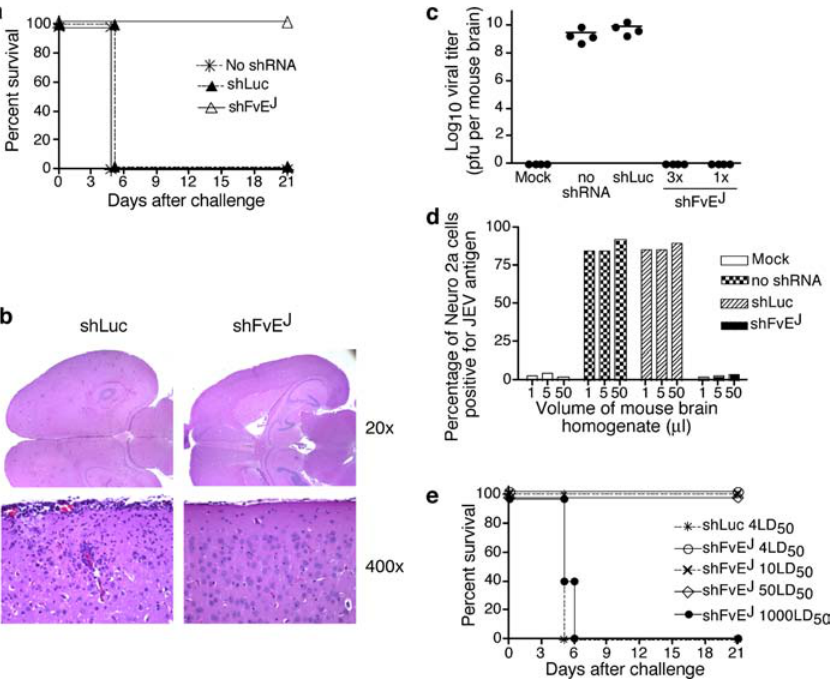
Figure 2. shFvE J Protects Mice against JEV-Induced Encephalitis (A) BALB/c mice (ten per group) were injected IC on days (cid:1) 4, (cid:1) 2, and 0 with 2 3 10 5 TU of either shFvE J or shLuc lentiviruses. On day 0, 30 min after injection of the third dose of lentivirus, they were injected at the same spot IC with four LD 50 of JEV, and the mice were monitored for survival over time. (B) Brain sections from shFvE J treated mice reveal no flavivirus-induced pathology. Representative photomicrographs of hematoxylin and eosin-stained horizontal brain sections obtained from mice treated with shFvE J or shLuc lentivirus and infected with JEV for 5 d are shown at indicated magnifications. (C) Lack of infectious virus in the brains of shFvE J -treated mice. Mice were injected with lentiviruses and challenged with JEV as in (A), and their brain homogenates, obtained 5 d after JEV challenge, were plaque-titrated on BHK21 cell monolayers. For shFvE J lentivirus, viral titers after a single (1 3 ) as well asthree(3 3 ) administrationsareshown.Theviraltitersareshownaslogplaque-formingunitspertotalbrain.Eachsymbolrepresents anindividualmouse. (D) Brains from shFvE J treated mice are free of infectious virus. Brain homogenates in (C) were pooled, 1, 10, or 50 l l of pooled homogenate were inoculated onto Neuro 2a cells, and the viral replication was monitored by flow cytometry 5 d later. (E) A single IC injection with shFvE J is sufficient for protection against JE encephalitis. Mice (five per group) were injected IC with 2 3 10 5 TU of shLuc or shFvE J , challenged 30 min later with indicated doses of JEV, and observed for survival over time. DOI: